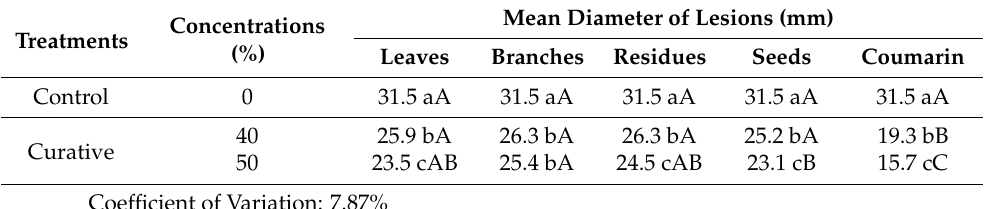
Coefficient of Variation: